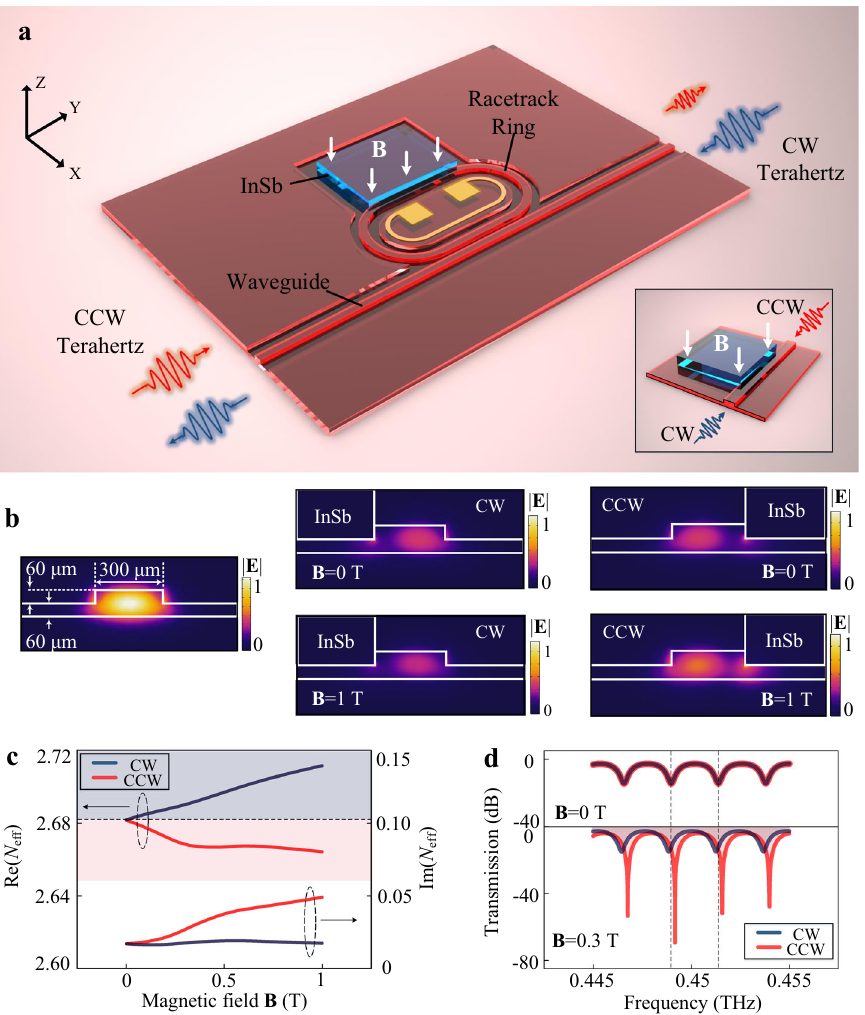
Fig. 1 Schematic of the designed on-chip terahertz isolator. a Schematic of the on-chip terahertz isolator, including a ridge waveguide, a racetrack ring resonator, a piece of InSb, and a metal electrode (the inset shows the detail of the nonreciprocal region). b Simulated normalized electric fi eld distribution (| E | ) of the ridge waveguide and the nonreciprocal region (in clockwise (CW) and counterclockwise (CCW) directions). c Calculated real (Re( N eff )) and imaginary (Im( N eff )) part of effective refractive indices of the nonreciprocal region with the increase of the magnetic fi eld. d Transmission properties of the chip in reciprocal ( B = 0 T) and nonreciprocal states ( B = 0.3 T). In the calculations, the temperatures are set to 300